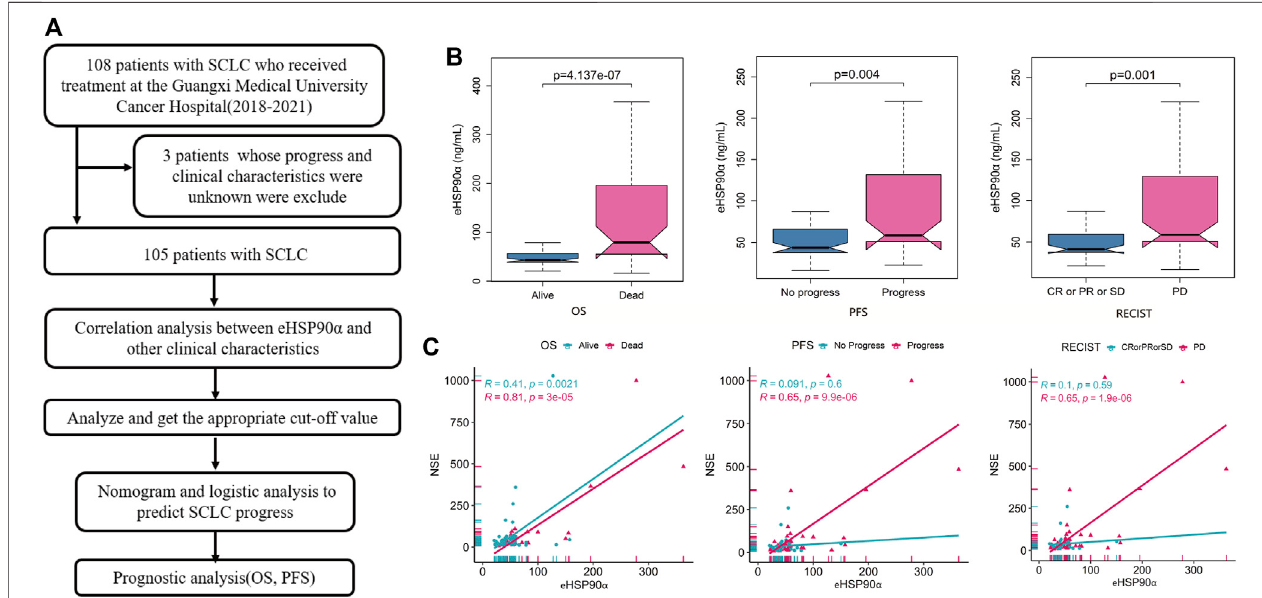
FIGURE 1 | Work fl ow diagram and association of eHSP90 α with clinical outcomes and NSE (A) Work fl ow (B) Box-plot shows the expression of eHSP90 α in different outcome states of OS, PFS, and RECIST (C) Scatter plots display the relationship between two continuous variables, eHSP90 α and NSE; different colors represent different OS, PFS, and RECIST states (NSE μ g/L, eHSP90 α ng/mL) Overall survival, OS; progression-free survival, PFS; Response Evaluation Criteria in Solid Tumors, RECIST.